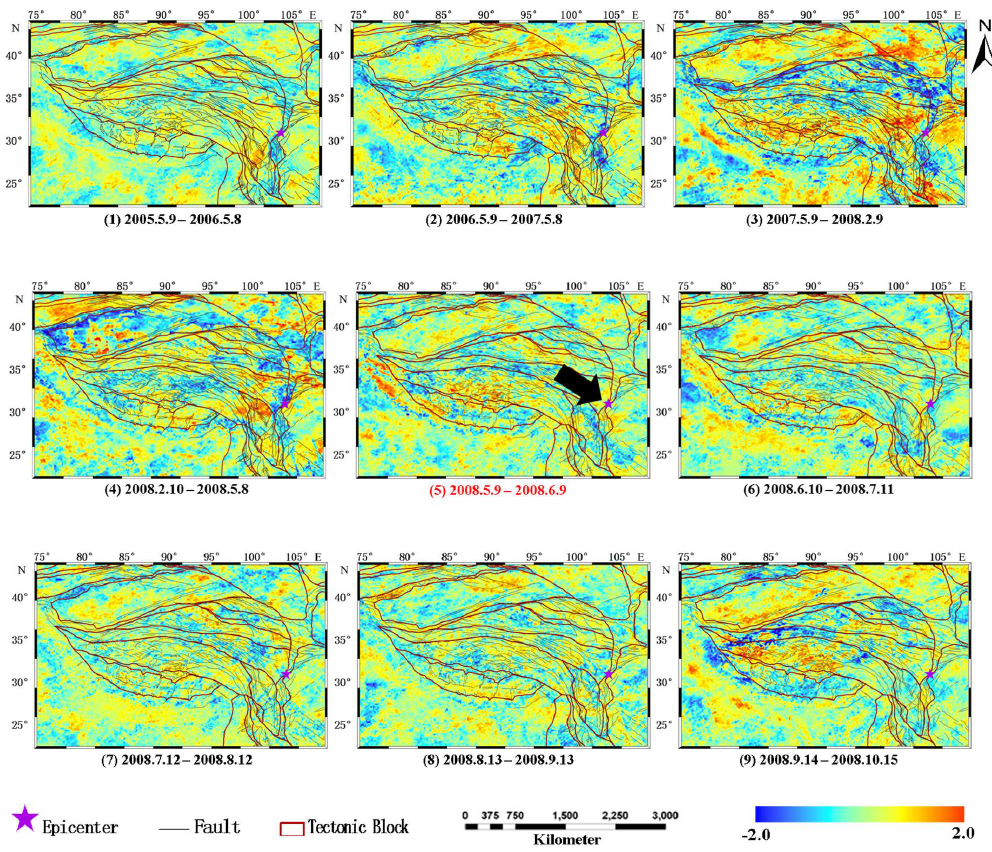
Figure 7. Thermal infrared (TIR) anomalies spatio-temporal presentation of the Ms 8.0 Wenchuan earthquake based on the proposed tectonic thermal infrared anomalies (TTIA) method on the Tibetan Plateau.